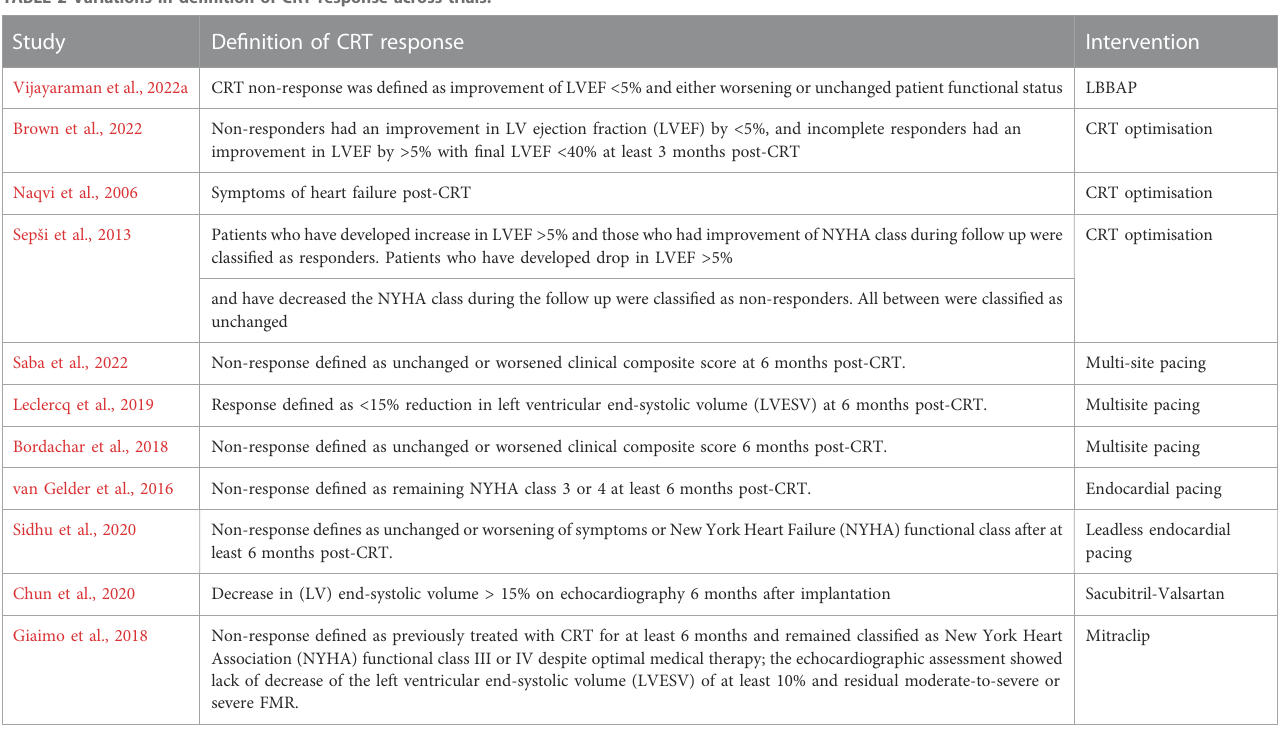
TABLE 2 Variations in de fi nition of CRT response across